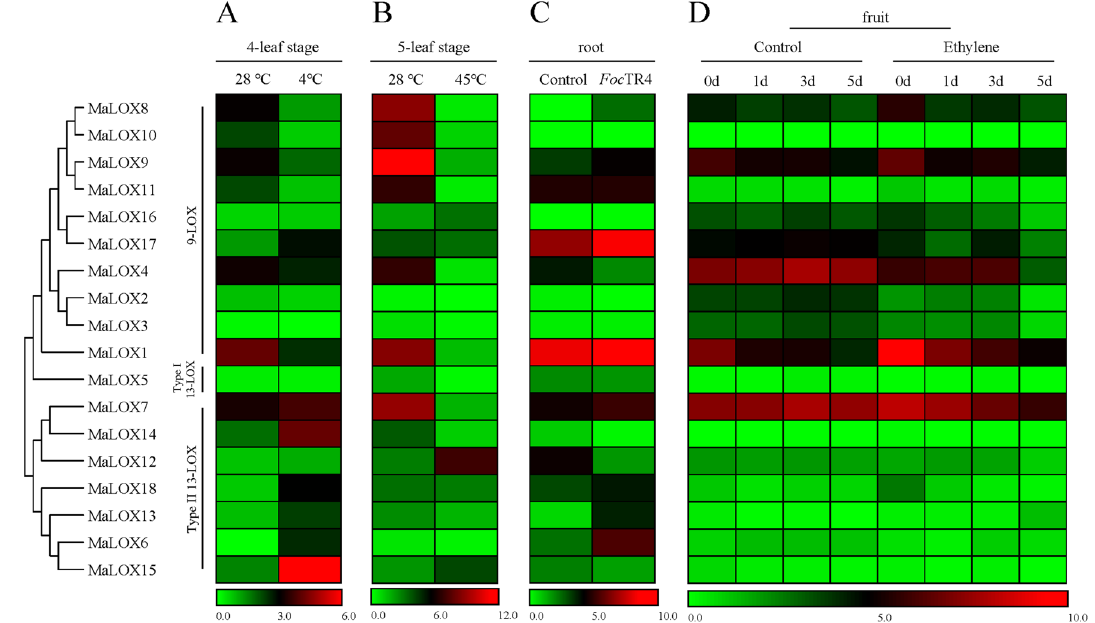
Figure 9. Diagram for the expression of all the MaLOX gene family members. ( A ) Leaf transcriptome data of 4-leaf stage ‘Tianbaojiao’ banana treated with 24 h 4 °C low temperature and 28 ℃ control; ( B ) leaf transcriptome data of 5-leaf stage ‘Tianbaojiao’ banana treated with 3 days 45 °C high temperature and 28 °C control; ( C ) root transcriptome data of Foc TR4 treated ‘Tianbaojiao’ banana; ( D ) fruit transcriptome data of ‘Tianbaojiao’ banana at natural ripening and ethylene induced ripening